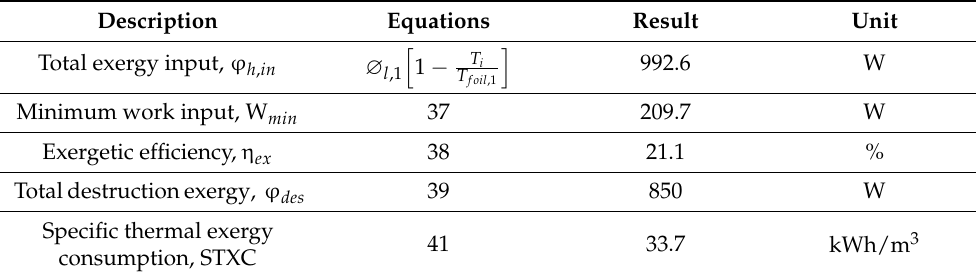
Table 6. Case study of the exergy analysis for the V-MEMD